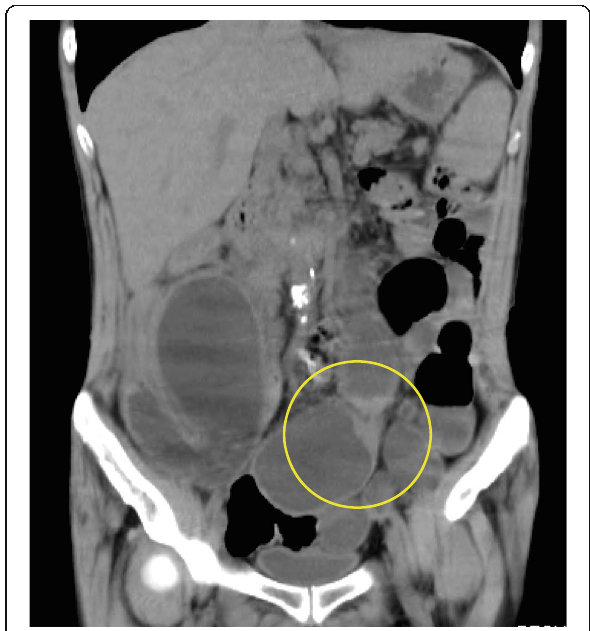
Fig. 2 The wall of the small bowel is thick and stenosed, as seen on computed tomography (yellow